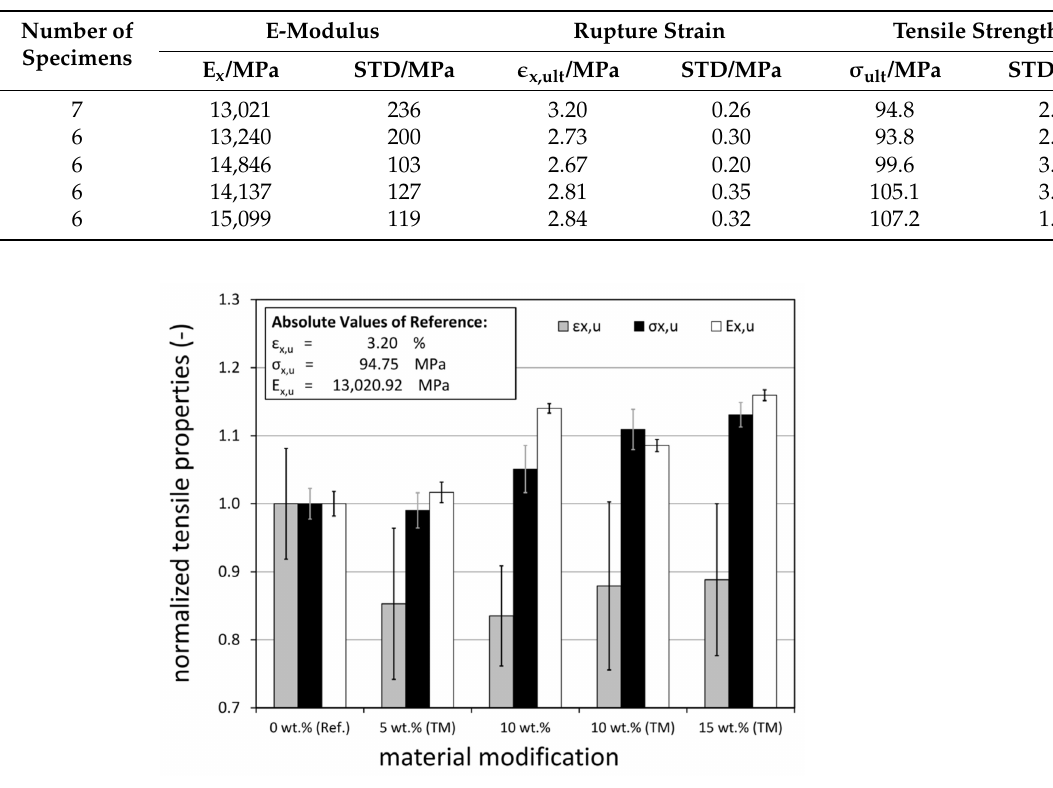
Table 1. Overview of matrix modifications and static test results.